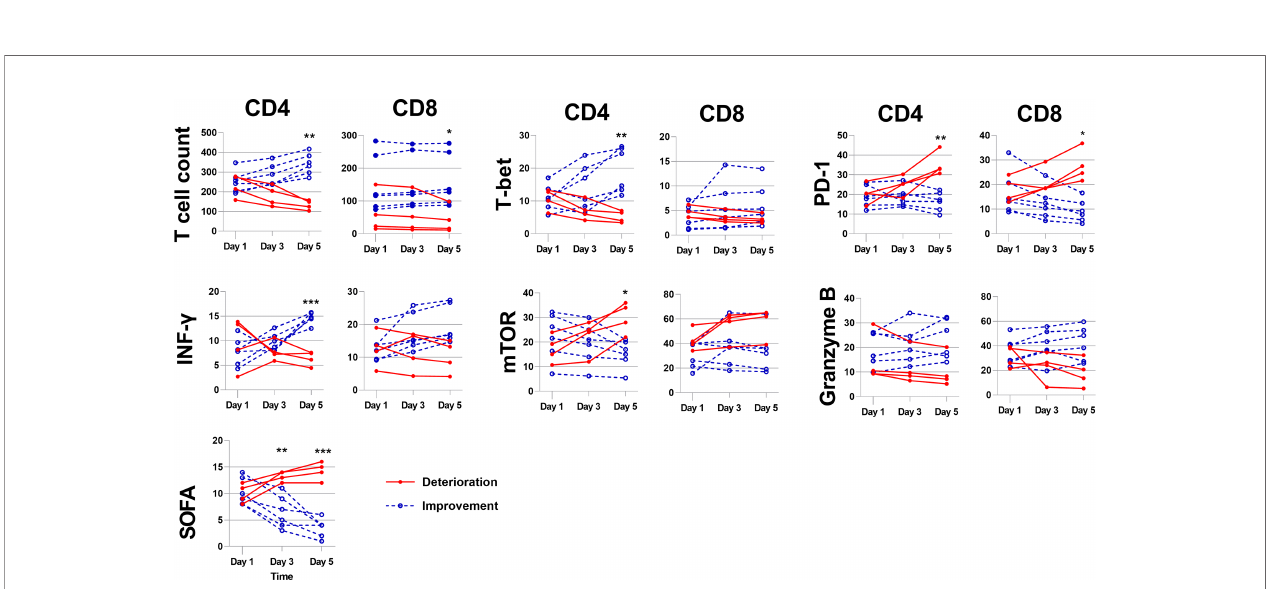
FIGURE 3 | The immune parameters of septic patients were continuously monitored. Changes mTOR, T bet, PD-1, IFN- g and Granzyme B expression by CD4+ T cells and CD8 + T cells between days 1, day 3 and 5 after the admission to the ICU for sepsis. *p<0.05; **p<0.01; ***p<0.001.